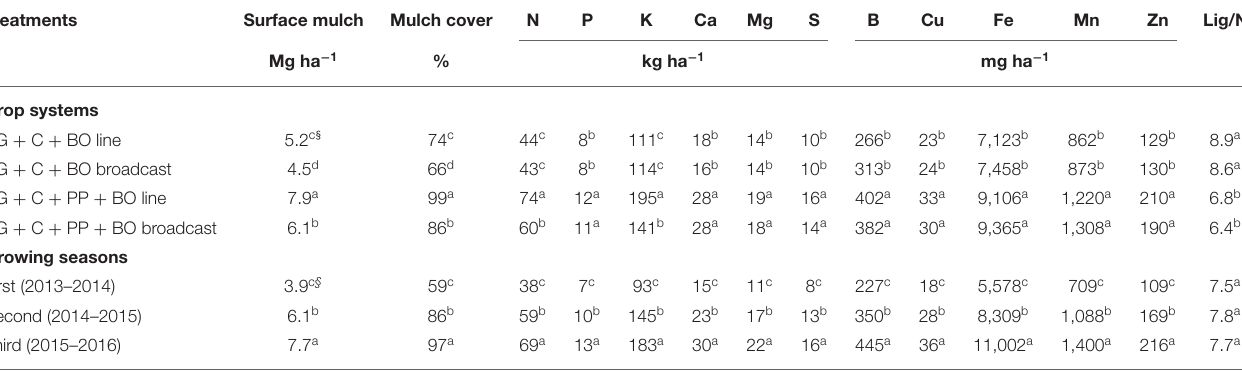
TABLE 9 | Surface mulch quantity, mulch cover, nutrient contents, and lignin/N ratio (Lig/N) in surface mulch of palisade grass intercropped with corn (PG + C) and with corn and pigeon pea (PG + C + PP) to silage with black oat (BO) oversown in lines and broadcast in three growing seasons after grazing by lambs. Treatments Surface mulch Mulch cover